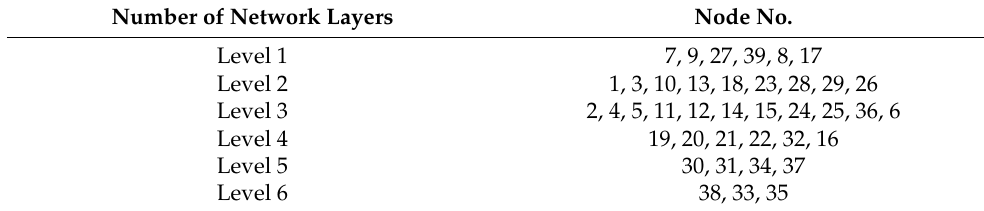
Table 3. Network-specific decomposition process.